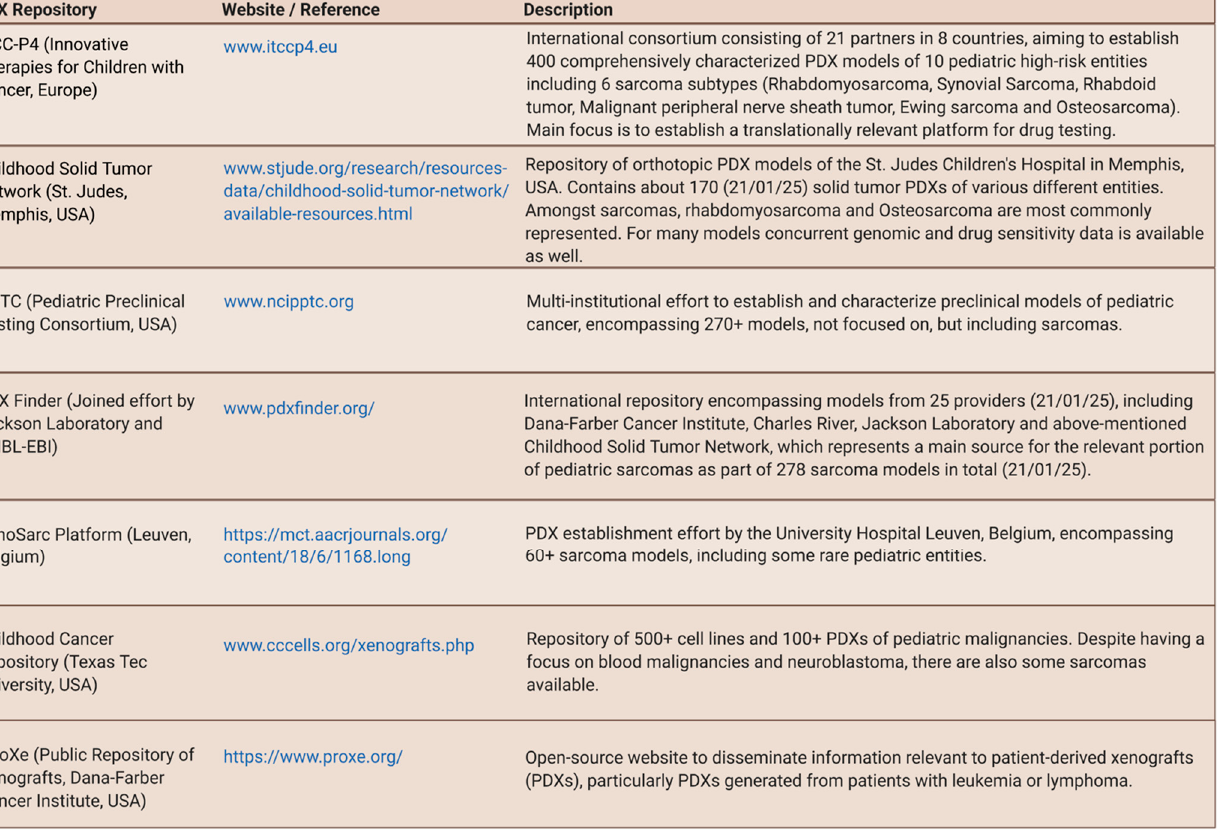
Figure 4. Selection of PDX-repositories relevant for pediatric sarcoma.